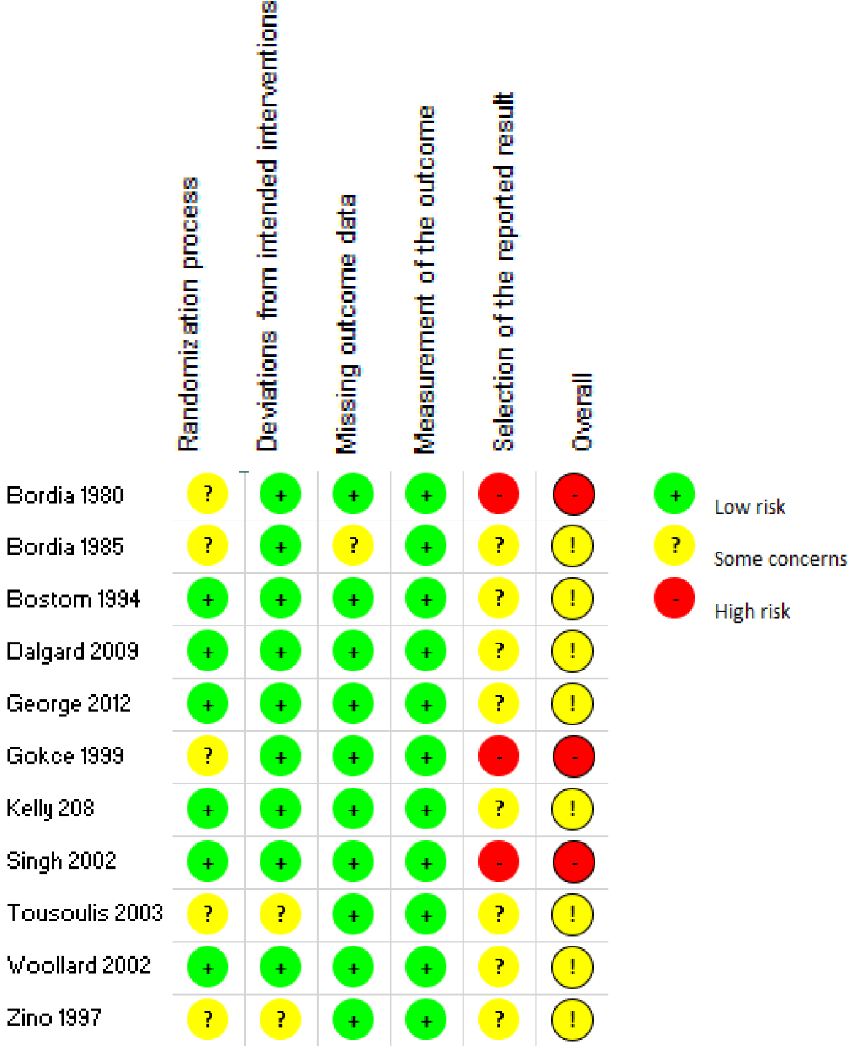
Figure 2. Summary of risk of bias results.